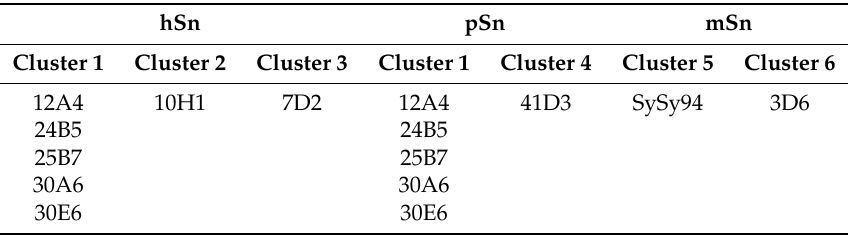
Table 2. Clustering of the different mAb based on the site on Sn they bind. Each column indicates the mAbs that are grouped in the same cluster for, respectively, hSn, pSn, and mSn.